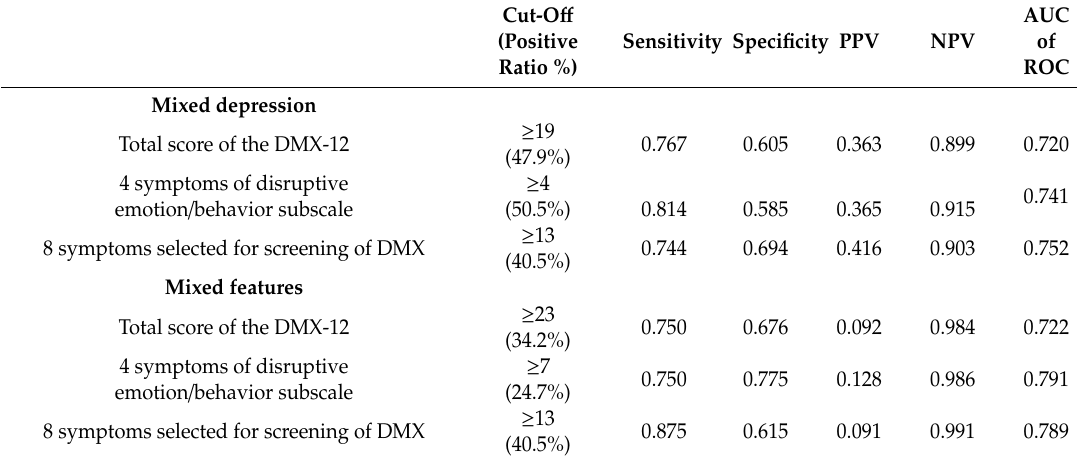
Table 3. Results of ROC analyses using total and cluster scores of the